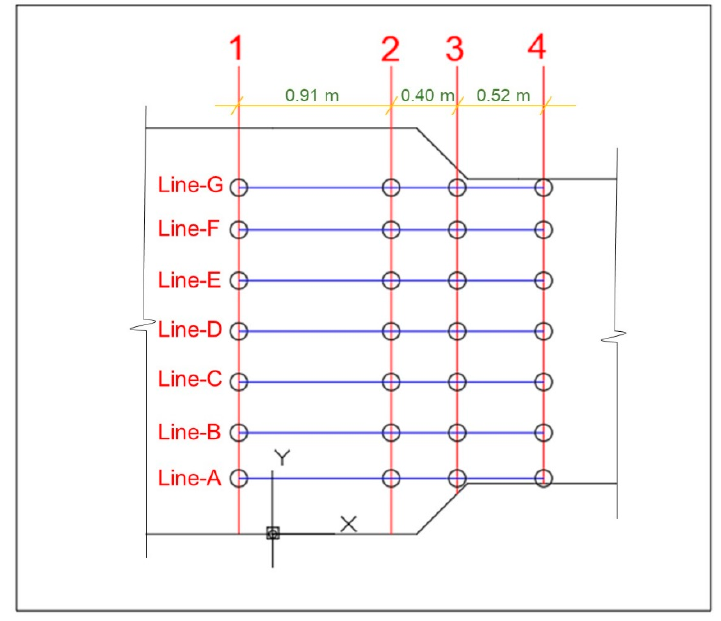
Figure 5. Selected points for the ADV data collection.